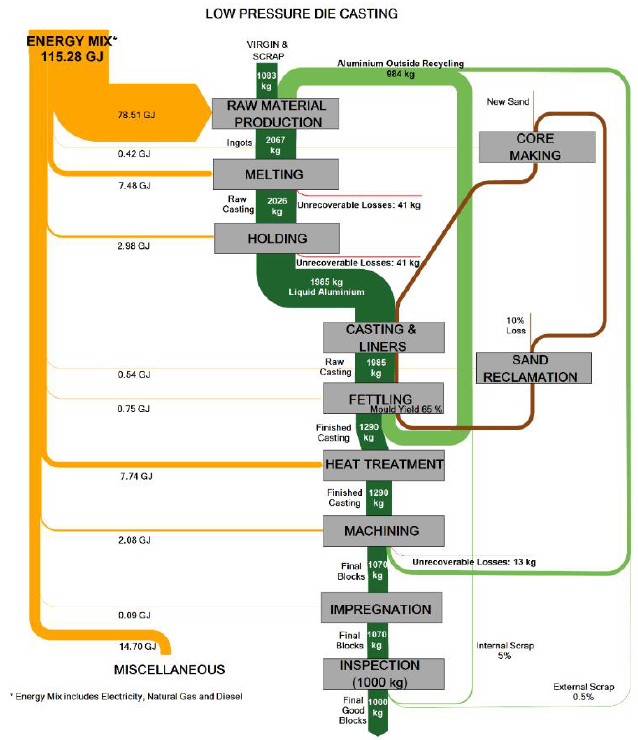
Figure 20. Energy and material flow in low-pressure die casting (LPDC), showing that 1000 kg of good castings require the melting of 2067 kg of Al and 115.28 GJ.